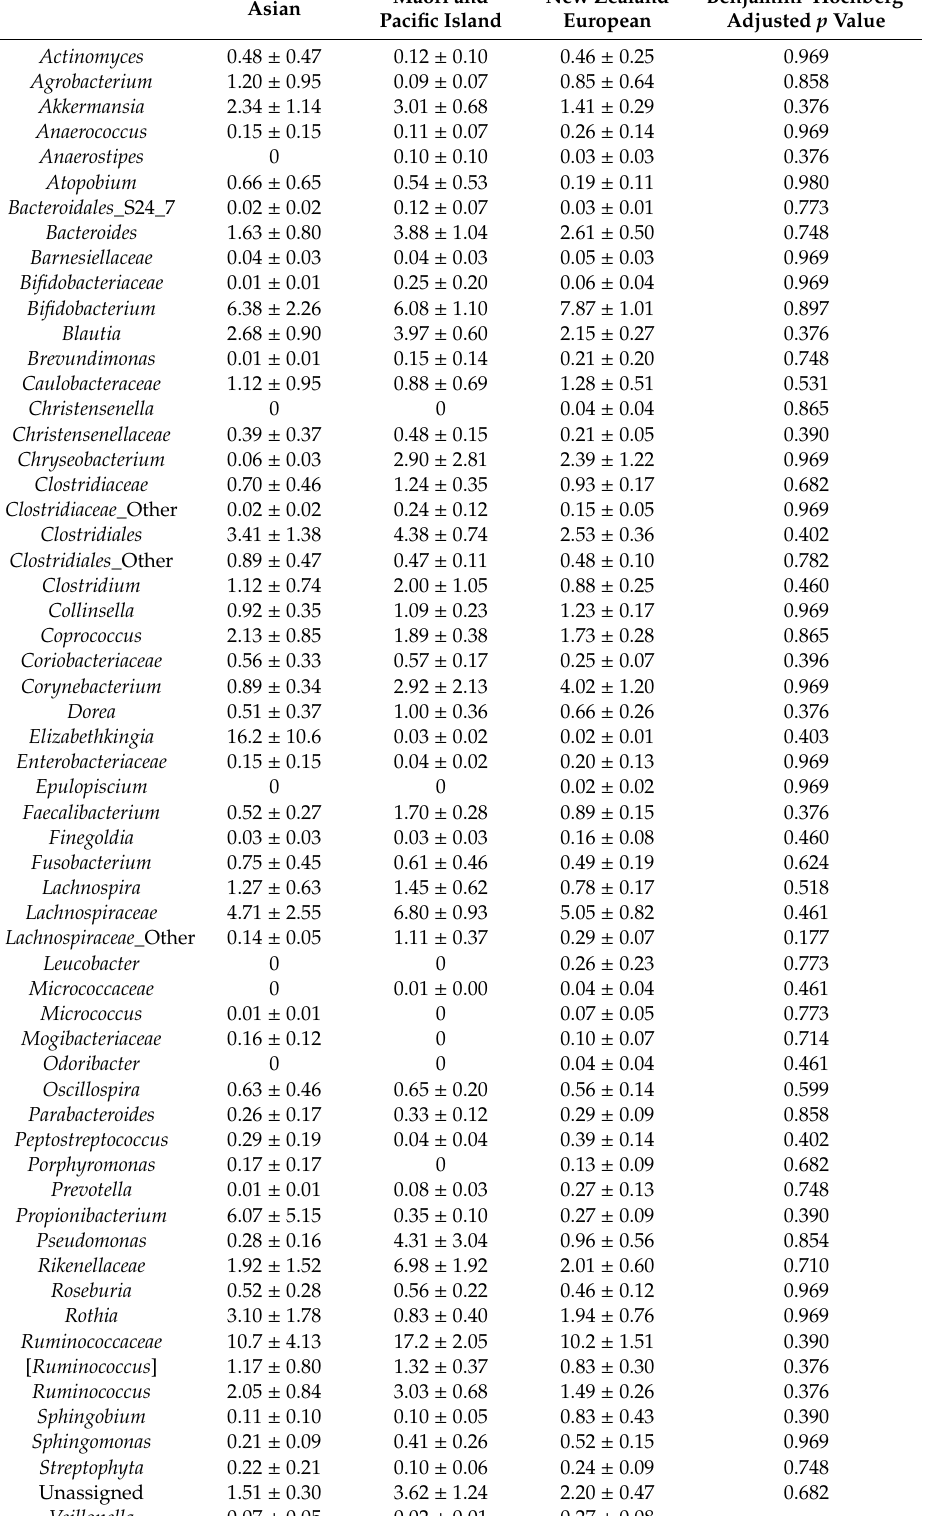
Table 1. Relative abundance of bacteria at the genus level in breast milk categorized according to the mother’s